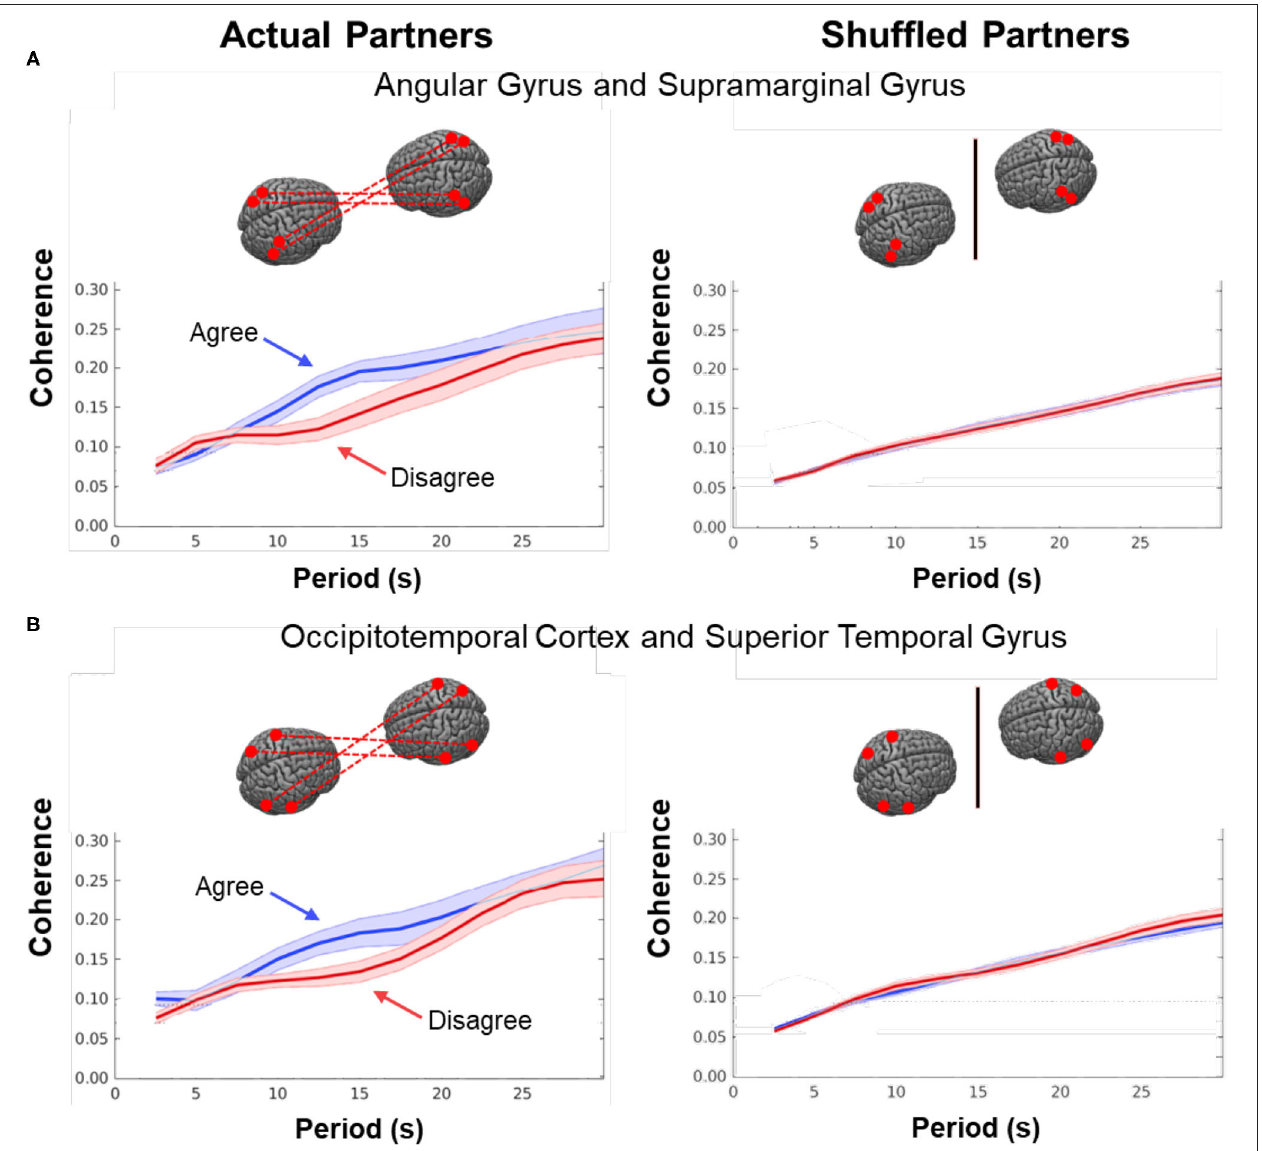
FIGURE 7 | Cross-brain coherence. Signal coherence between dyads (y-axis) is plotted against the period (x-axis) for the Disagree (red) and Agree (blue) conditions (shaded areas: ± 1 SEM). The left column shows coherence between actual partners, and the right column shows coherence between shuffled partners. Greater signal coherence was observed between actual partners in (A) angular gyrus to supramarginal gyrus and (B) occipitotemporal cortex to superior temporal gyrus. In contrast, no significant differences were found in coherence between shuffled partners during either condition.